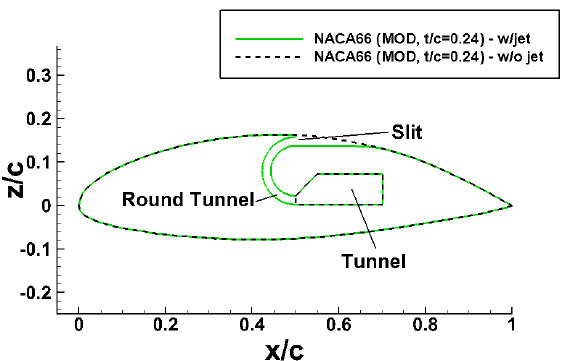
Figure 1. NACA66 (MOD, t/c = 0.24) geometry with jet and without jet. In Figure 1, the tunnel is the passage through which water flows from the shaft to the propeller blades to inject a jet. The slit is the jet opening in the hydrofoil, and the round tunnel is the passage connecting the tunnel and the slit. In the case without a jet section, since a jet is not injected, only the tunnel exists inside the hydrofoil. In the geometry with a jet section, the slit, round tunnel, and tunnel exist inside the hydrofoil to inject the jet. This section is designed without an angled part as possible in the hydrofoil after the slit so that the jet injected from the slit can flow along the hydrofoil. In addition, in the case with a jet section, all hydrofoil geometry except around the slit was made with the same geometry as without a jet section. The shape and location of the slit and tunnel were selected based on Eom et al. [16], who optimized the shape of the jet nozzle through 2D and 3D hydrofoil studies that injected a jet. The position of the slit is in the center of the chord, and the height of the tip was selected as 25% of the slit height. Based on the NACA66 (MOD, t/c = 0.24) section in Figure 1, a Coanda propeller that injects a jet from the propeller blade surface was manufactured. The specifications of the propeller are shown in Table 1. The diameter of the propeller (𝐷) is 250 mm, which is relatively large compared to other propellers to make inner structure, and the length of the chord (𝑐) is 50 mm. The geometry of the propeller was designed as a simple shape with only pitch without rake and skew as a basic study. Table 1. Parameters of the Coanda propeller used in the experiment. Parameter